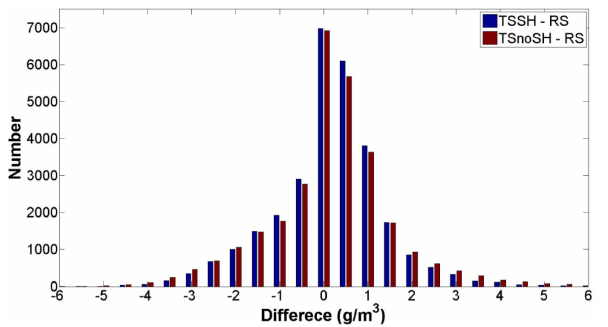
Figure 6. Time series of PCCs (upper) and RMSEs (down) be- tween different tomographic humidity profiles (TSSH blue line and TSnoSH red line) and the ones derived from radiosonde